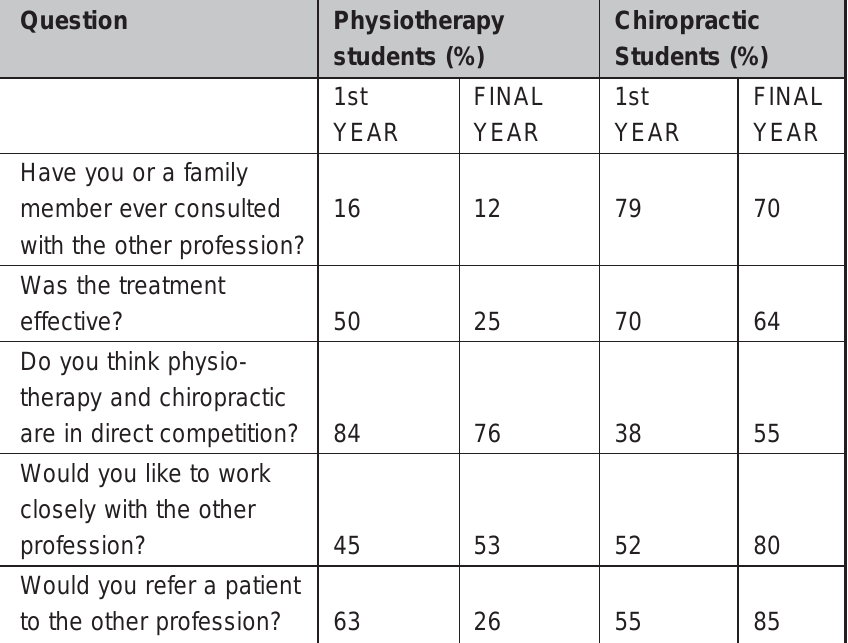
Table 1: Summary of physiotherapy and chiropractic students’ percep- tions and attitudes towards the others’